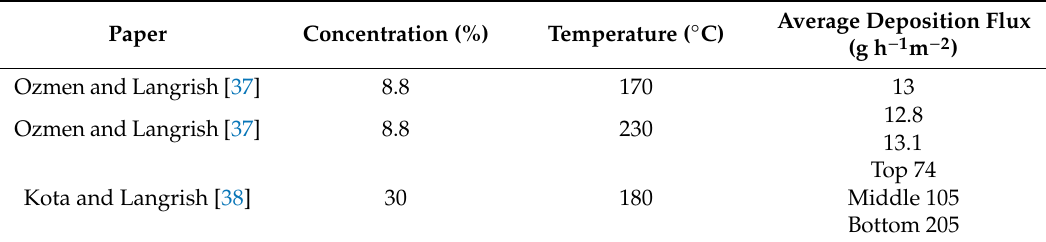
Table 3. Typical wall deposition fluxes in spray dryers from the literature, based on previous authors’ research on a previous, modified Niro Minor, pilot-scale spray